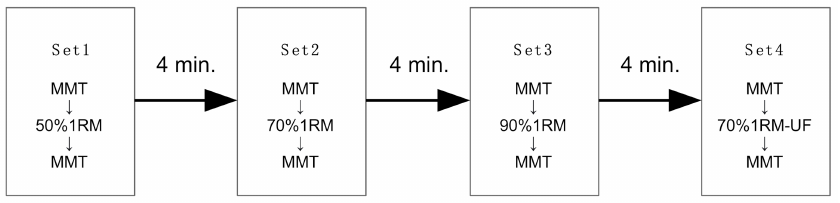
Figure 1. Study design. MMT—myotonometry assessment; 1RM—one-repetition maximum; UF—until